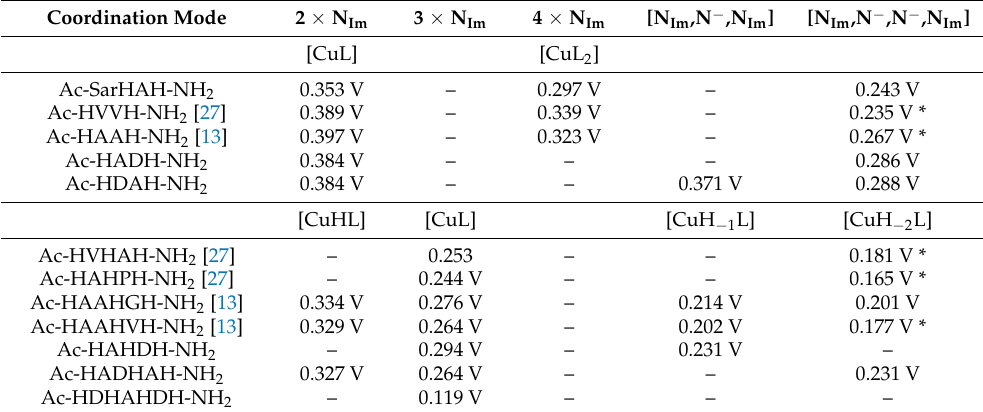
Table 4. Redox potentials (vs. NHE) of the Cu(II) complexes of ligands. Coordination Mode